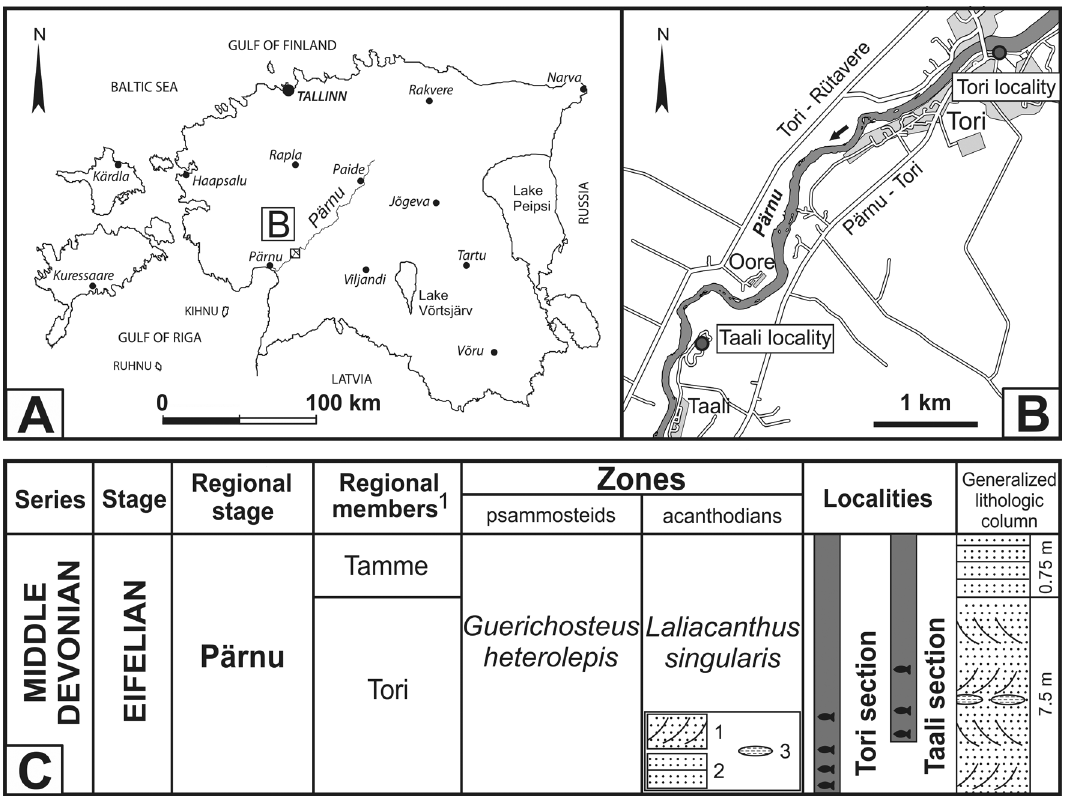
Fig. 1. A , map showing the position of localities along the Pärnu River in Estonia (adapted from Mark-Kurik & Põldvere 2012). B , Tori and Taali localities on the left bank of the Pärnu River. C , the stratigraphical position of the studied localities. 1 , Regional stratigraphical units of Estonia. Black fish figures mark the approximate stratigraphic levels in which the vertebrates are found. Abbreviations for the generalized lithologic column: 1, cross-bedded sandstone; 2, dense parallel-bedded sandstone; 3, lenses of clay (up to 1 m in